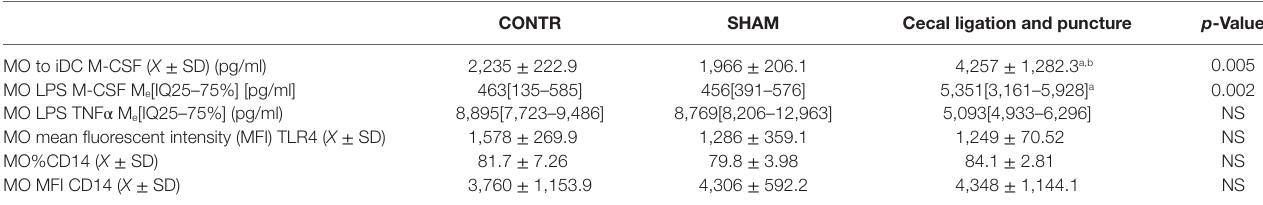
TaBle 1 | secretion of M-csF in il-4&gM-csF differentiated MO was elevated in animals surviving sepsis.